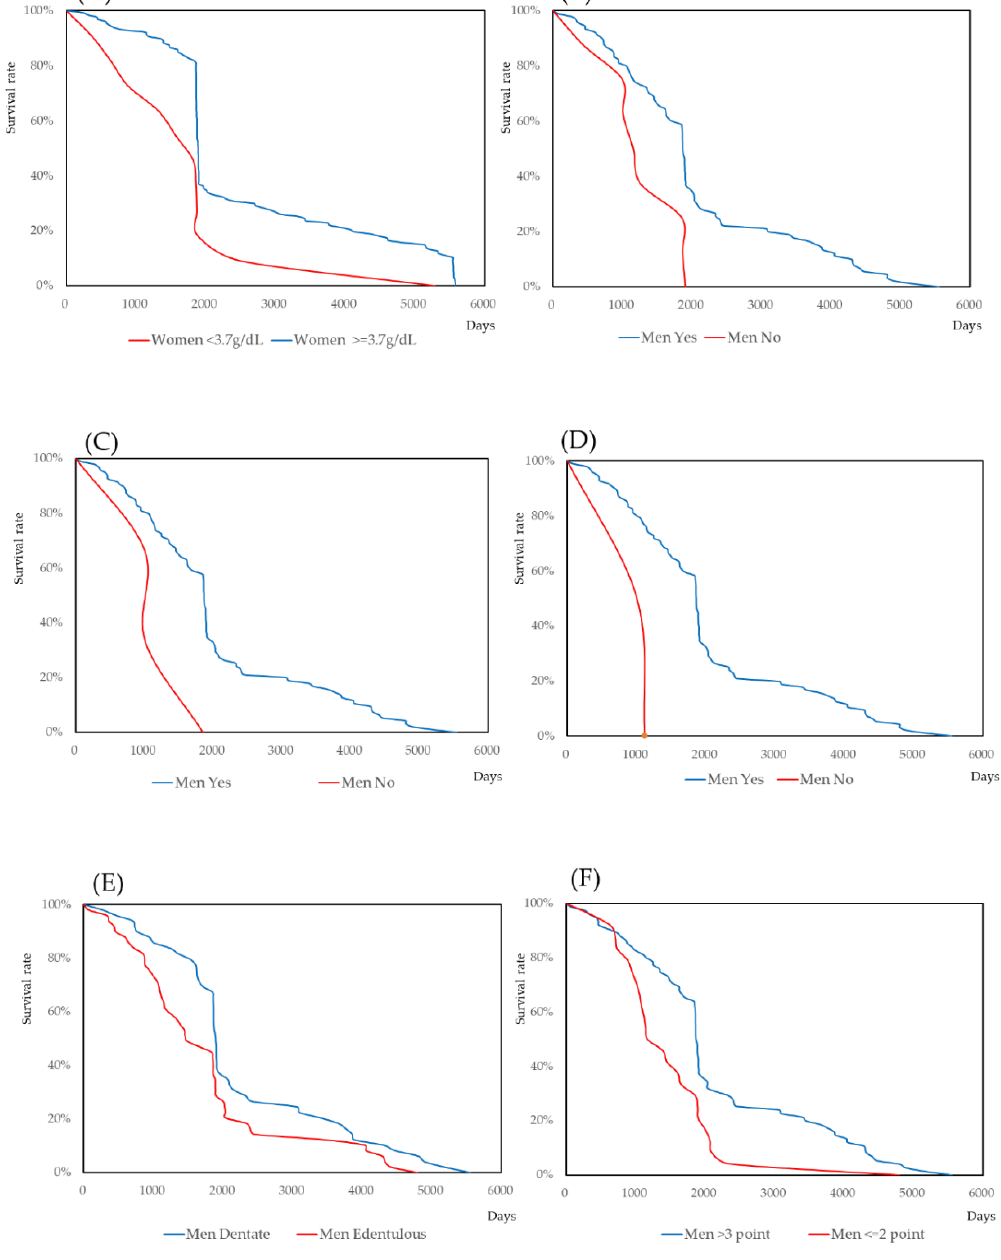
Figure 4. Survival curves of the significant factors for mortality. ( A ) Serum levels of albumin for women. ( B ) Ability to chew Konnyaku-jelly of men. ( C ) Ability to chew Tubular roll of boiled fish paste of men. ( D ) Ability to chew Steamed rice of men. ( E ) Edentulous. ( F )Intellectual activity of men.